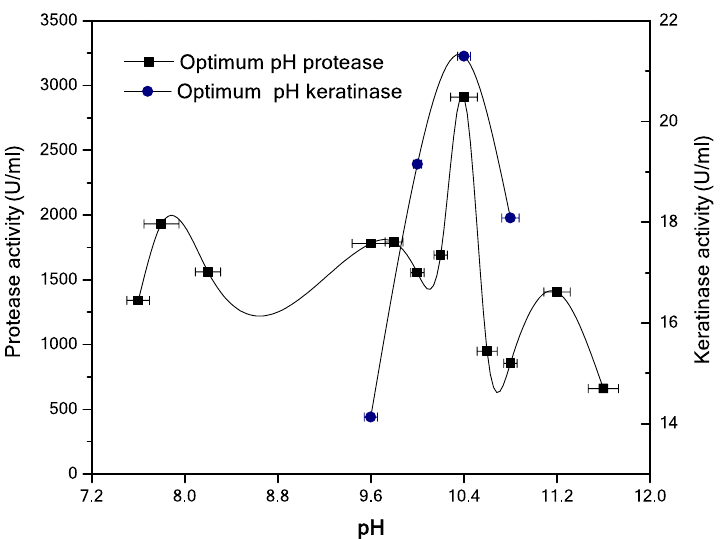
Figure 6. Optimal pH for protease using casein as the substrate and for keratinase using keratin-azure as the substrate.